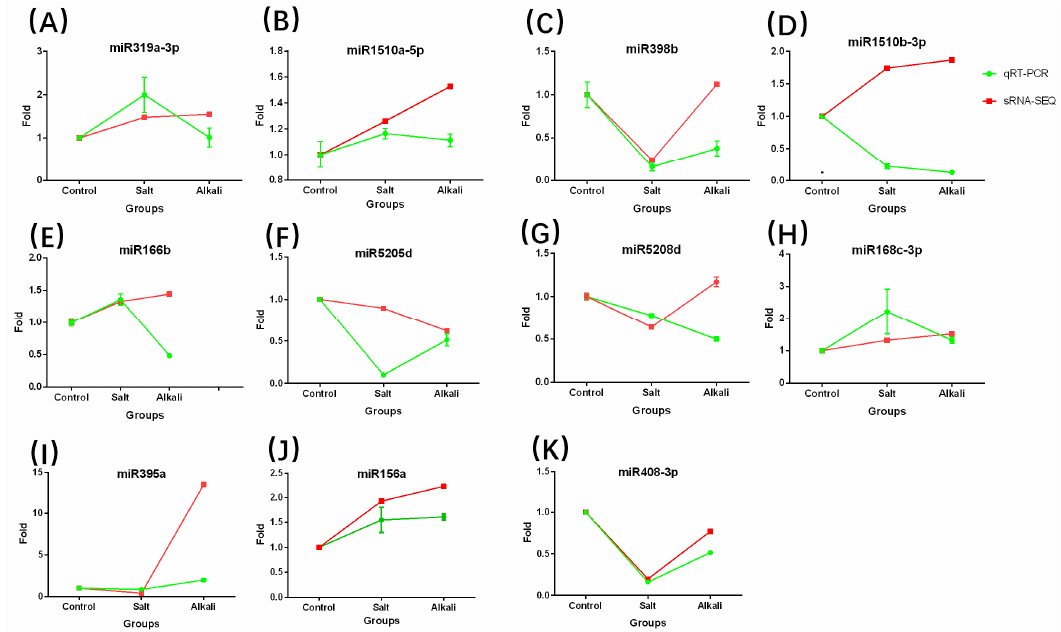
Figure 7. Validation of 11 miRNAs expressions in M. truncatula using RT-qPCR. ( A – K ) Expressional abundance of each miRNA gene in the control sample was set as 1 and fold changes of each miRNA gene relative to the control sample were calculated. The red plots are small RNA sequencing results and green represents the RT-qPCR results.